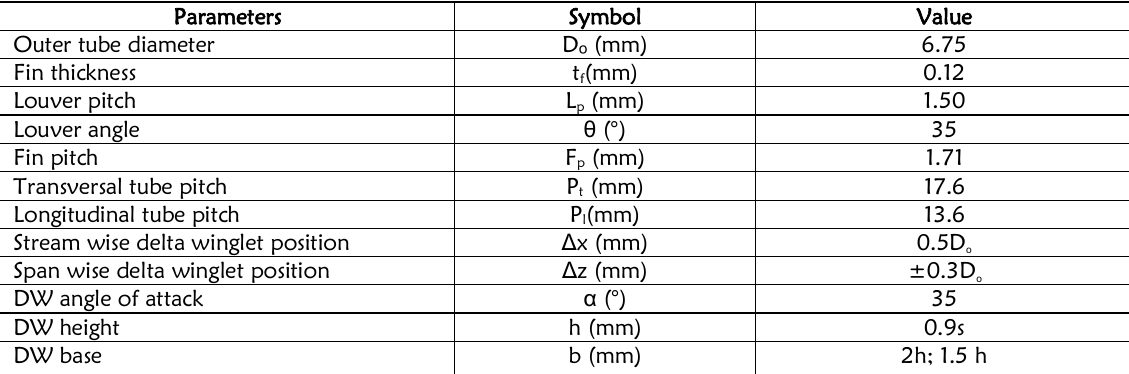
Table 3: Size dimensions of the multifarious heat exchanger (DW = delta winglet) [27]. Parameters